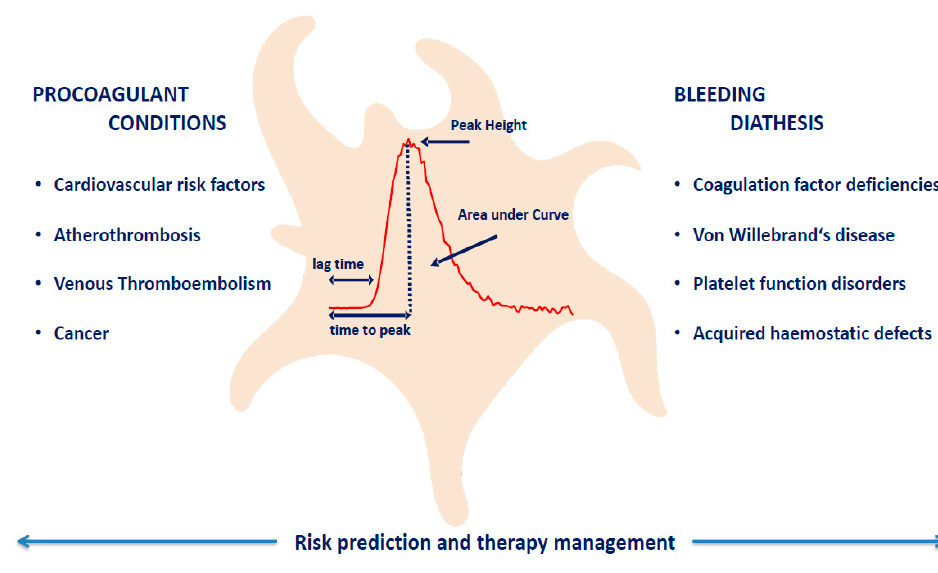
Figure 1. Thrombin Generation: Clinical Applications.